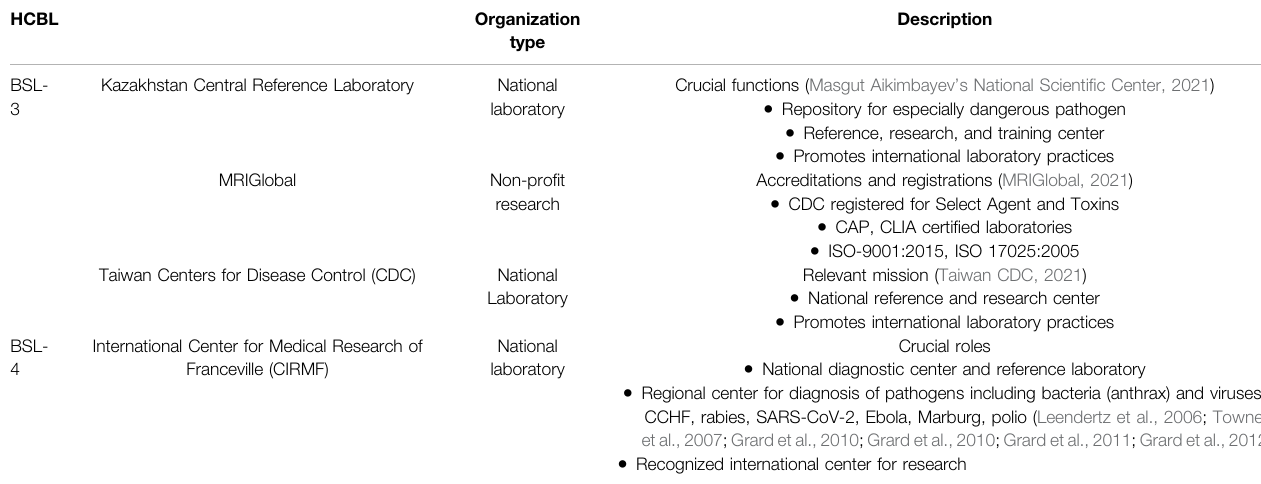
TABLE 1 | Summary of high-containment biological laboratories (HCBL) described in case histories. HCBLs from three continents are